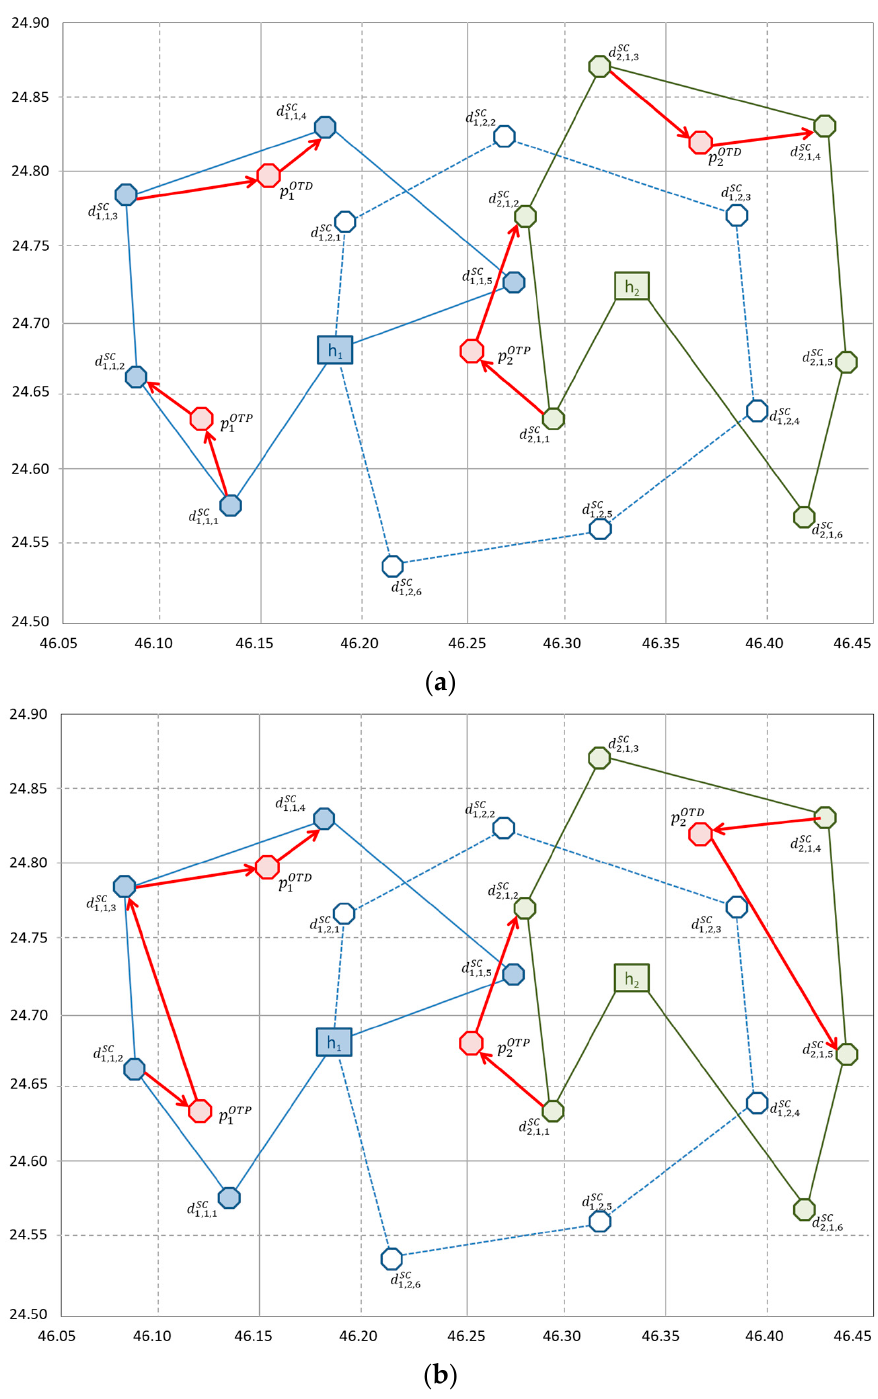
Figure 14. Scheduled routes and shuttle services in Scenario 3 and 4: ( a ) The open tasks are assigned to the scheduled routes real-time, time frame constraints are not taken into consideration; ( b ) The open tasks are assigned to the scheduled routes real-time with time frame constraints.